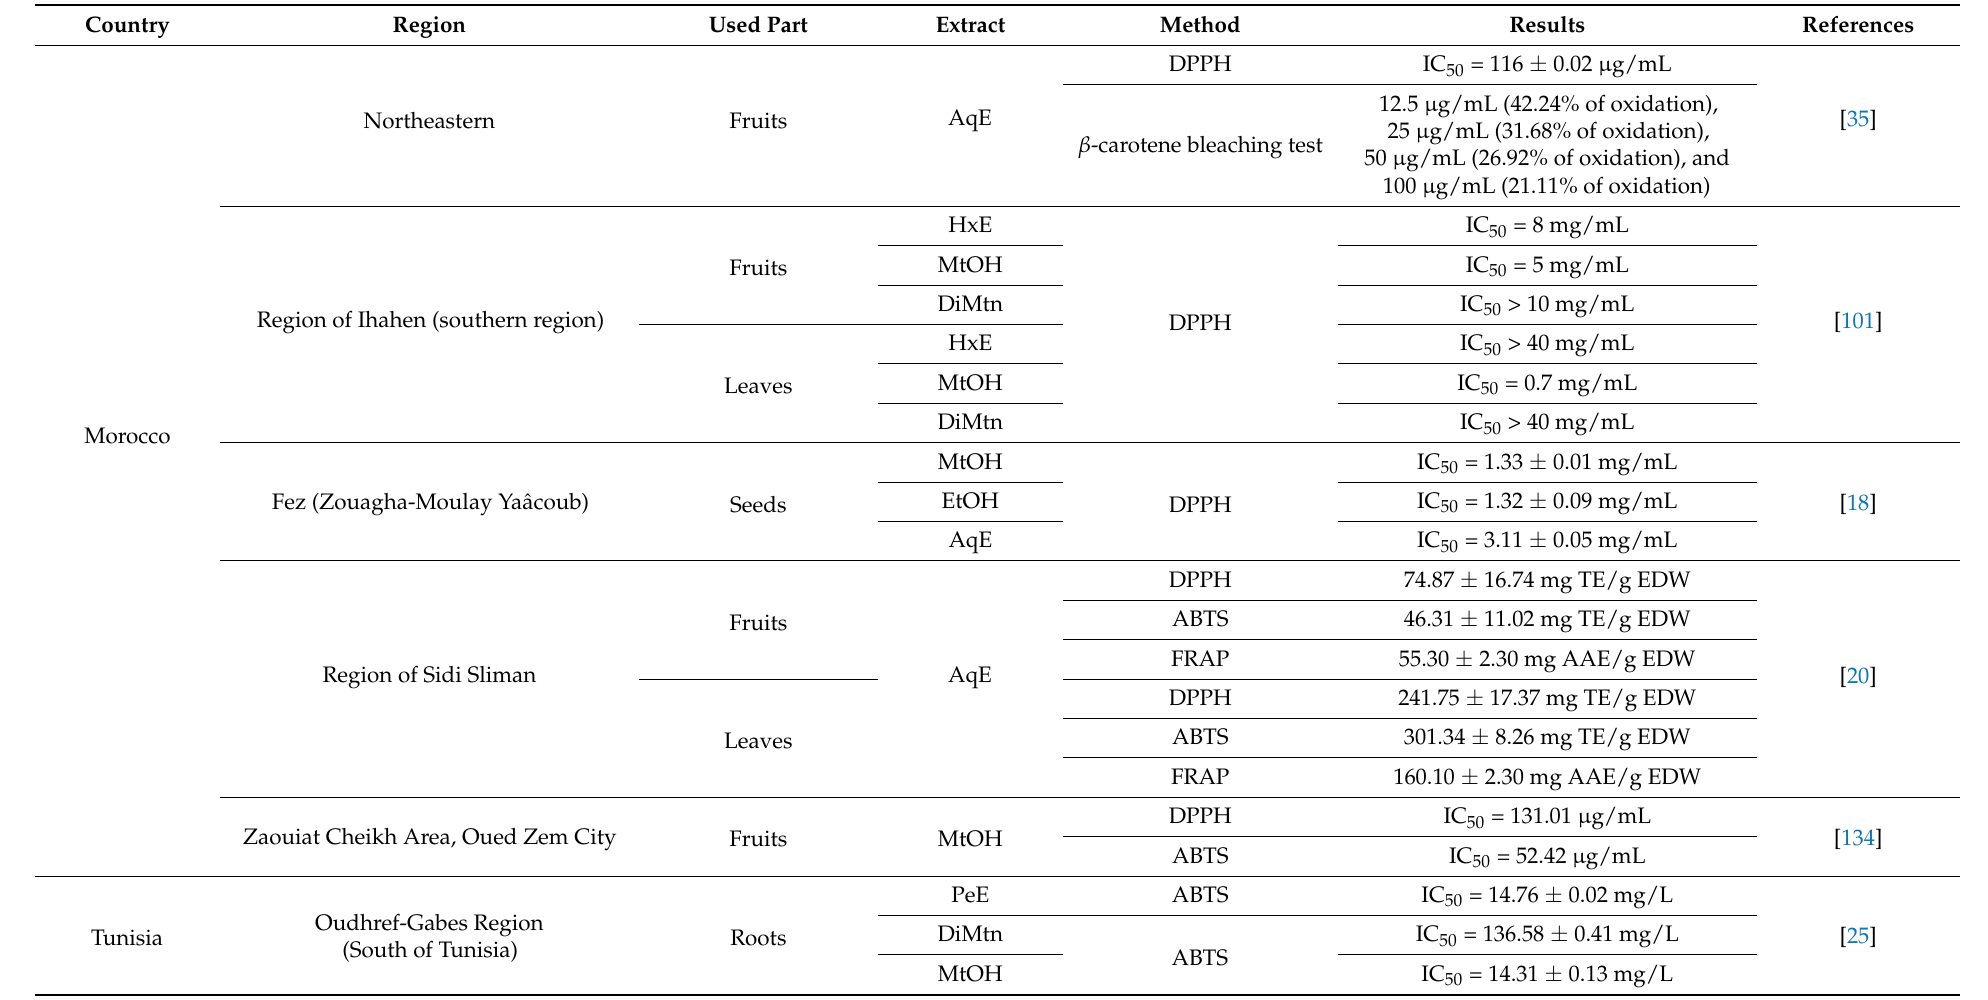
Table 4. The anti-oxidant activities of the Z. lotus